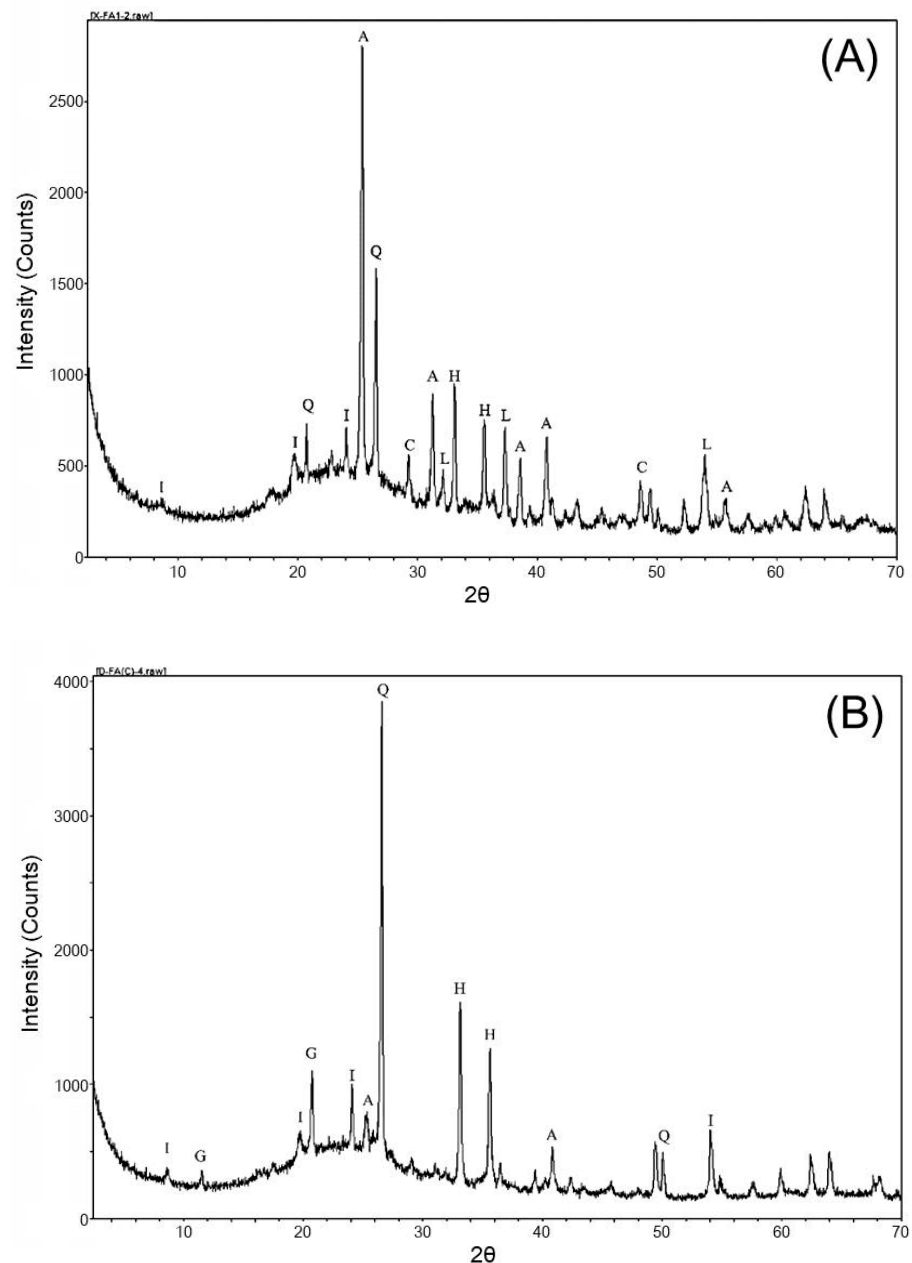
Figure 6. Powder XRD patterns of the fly ashes from the Xilaifeng and Damo power plants. ( A ) x-fa1-2; ( B ) d-fa(c)-4. H, hematite; A, anhydrite; Q, quartz; C, calcite; I, illite; L, lime; and G,